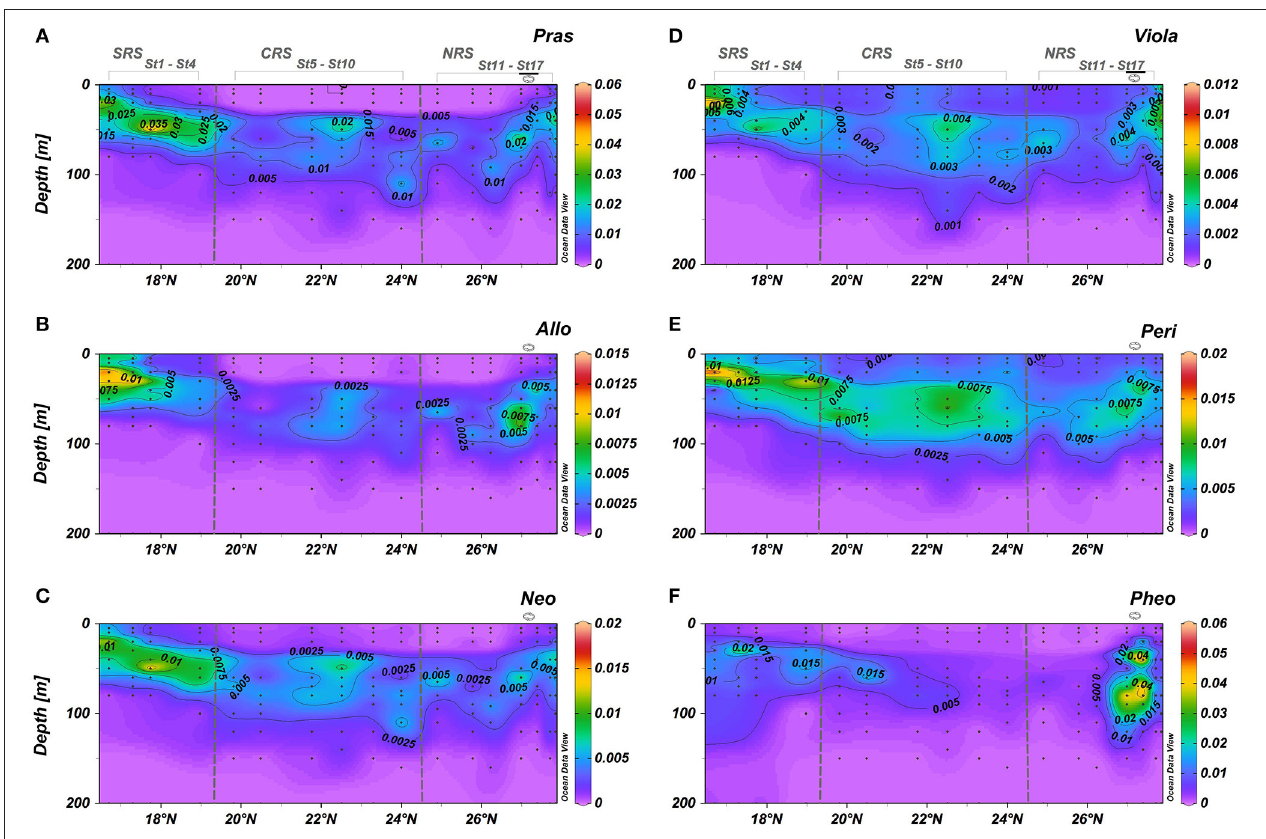
FIGURE 5 | Vertical cross sections for pigment concentrations (mgm − 3 ) across the south-north transect. (A) Prasinoxanthin; (B) Alloxanthin; (C) Neoxanthin; (D) Violaxanthin; (E) Peridinin; (F) Phaeopigments. Black dots represent sampling points. Eddy stations marked along the top of the upper